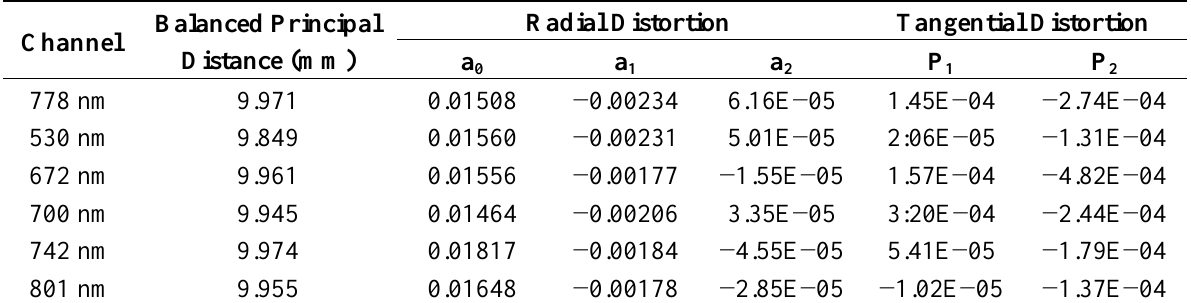
Table 4. Radial and tangential distortion parameters of the six MCA